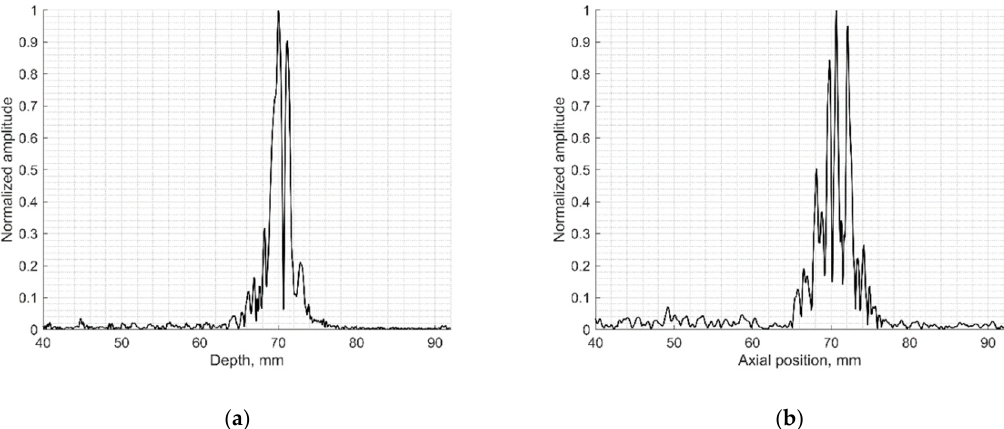
Figure 9. Comparison of signal envelopes backscattered from the inclined plane of slice thickness phantoms: ( a ) physical Model 538NH echoscopy and ( b ) digital phantom simulation.